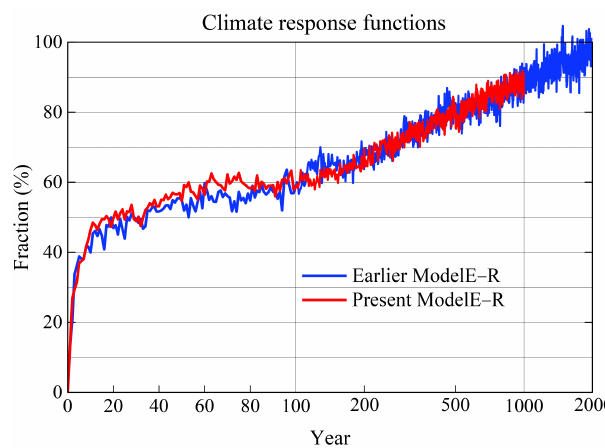
Figure 4. Climate response function, R(t) , i.e., the fraction (%) of equilibrium surface temperature response for GISS modelE-R based on a 2000-year control run (Hansen et al., 2007a). Forcing was in- stant CO 2 doubling with fixed ice sheets, vegetation distribution, and other long-lived